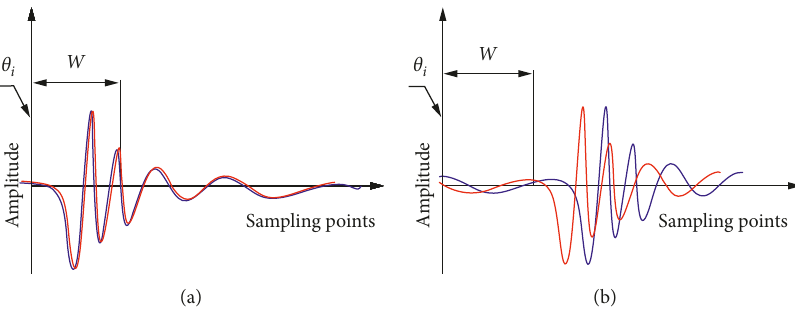
Figure 3: Principle of the preliminary selection of the starting point. (a) W areas include the main energy area of two fault components. (b) W areas do not contain the main energy area of two fault components. Correlation analysis for W 1 and W 2 areas intercepted at the same phase of two consecutive q revolutions. If the W 1 and W 2 areas include the main energy area of two fault components, where ρ ( W 1 , W 2 ) is greater than threshold M 1 , then the starting point is preliminarily selected at the phase position. If the W 1 and W 2 areas contain background noise or few fault features, where ρ ( W 1 , W 2 ) is less than M 1 , then the starting point should be reverified at the next phase.